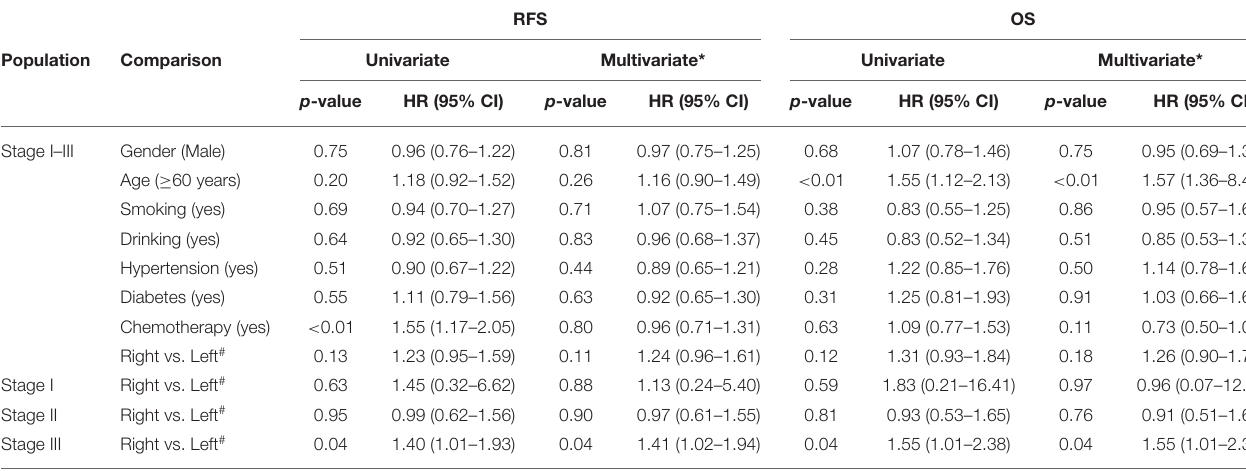
TABLE 2 | Cox analysis of common clinical characteristics and primary tumor location within 1,181 surgical patients with stage I–III CRC and subgroups stratified by TNM stage in the